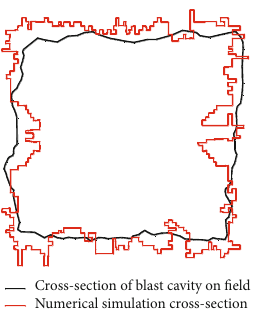
Figure 8: E ff ect comparison.